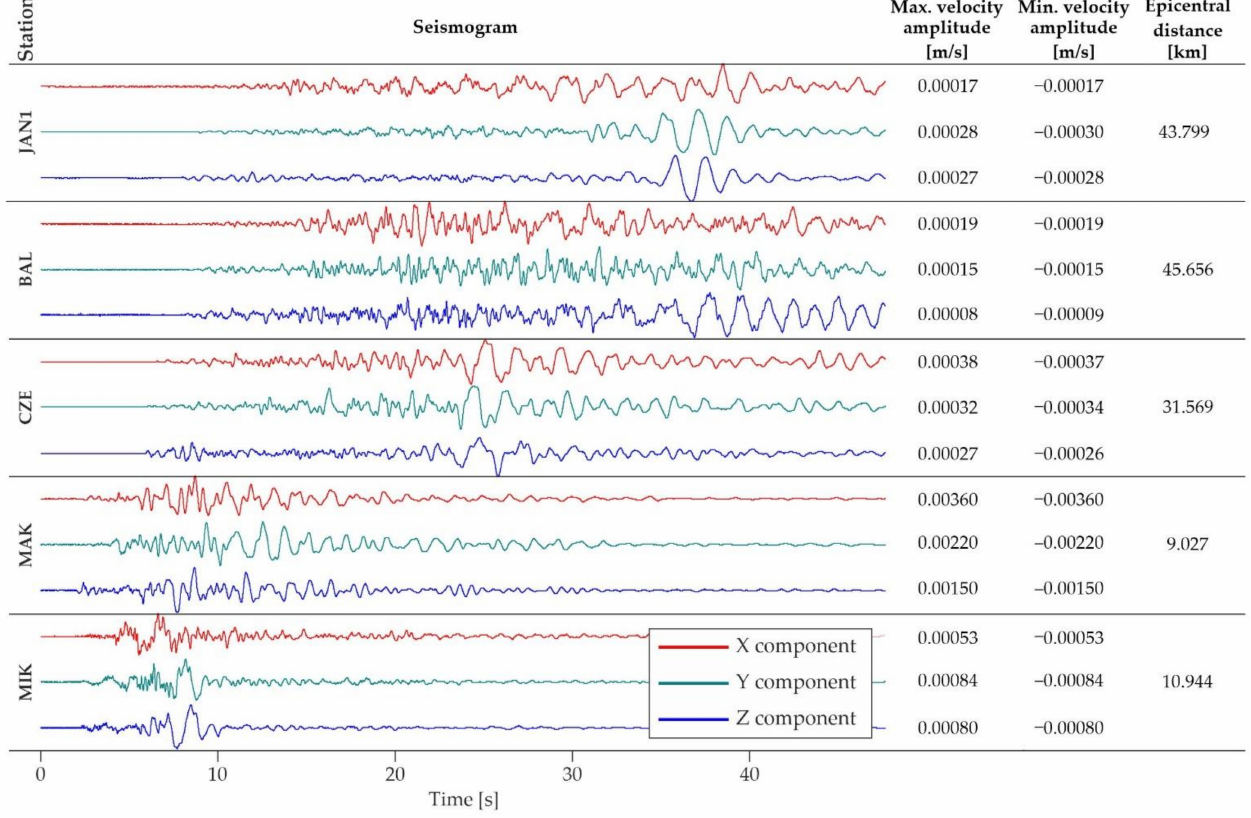
Figure 4. An example of a seismogram of the tremor of 8 November 2018 with seismic energy E = 4.0 · 10 8 J registered by seismic stations of the Upper Silesian Regional Seismological Network.